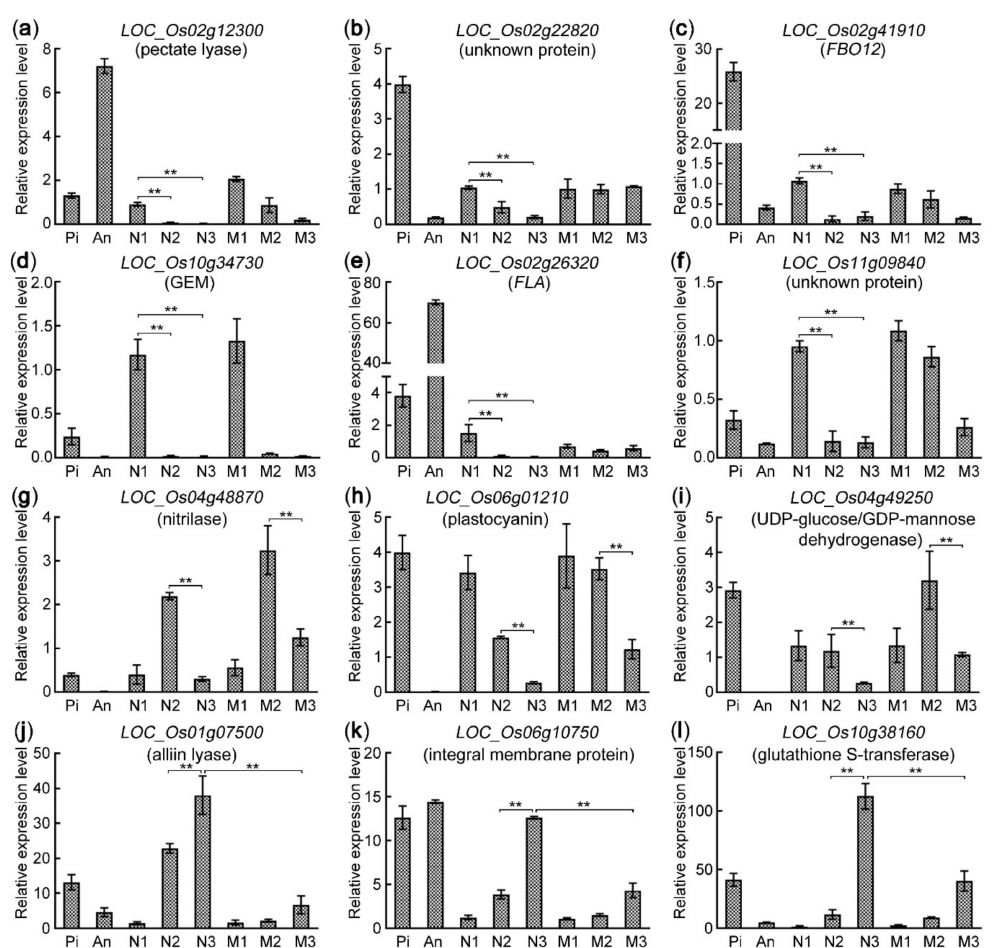
Figure 9. The qRT-PCR validation of gene expression patterns in rice WT and mutant feb . ( a – f ) The expression patterns of 6 pollen tube-related genes. ( g – i ) The expression patterns of 3 genes involved in the recognition and fusion of the male–female gametes. ( j – l ) The expression patterns of 3 genes involved in the zygote formation and the free endosperm nuclear division. Three biological replicates and three technical replicates of each sample were performed for qRT-PCR. Two asterisks (**, p < 0.01) represent significant differences according to Student’s t -test. An, mature anther; Pi, mature pistil before pollination; N1, WT pistil at 1–20 min after pollination; N2, WT pistil at 3.5 HAP; N3, WT pistil at 8 HAP; M1, the mutant pistil at 1–20 min after pollination; M2, the mutant pistil at 3.5 HAP; M3, the mutant pistil at 8